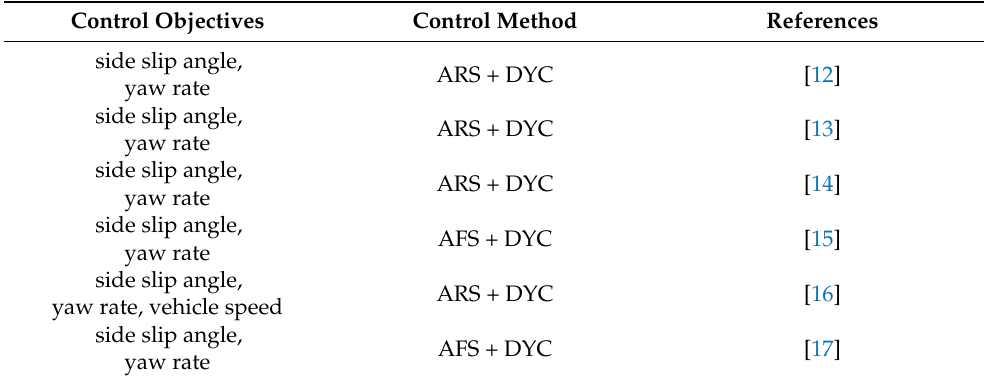
Table 1. Technical